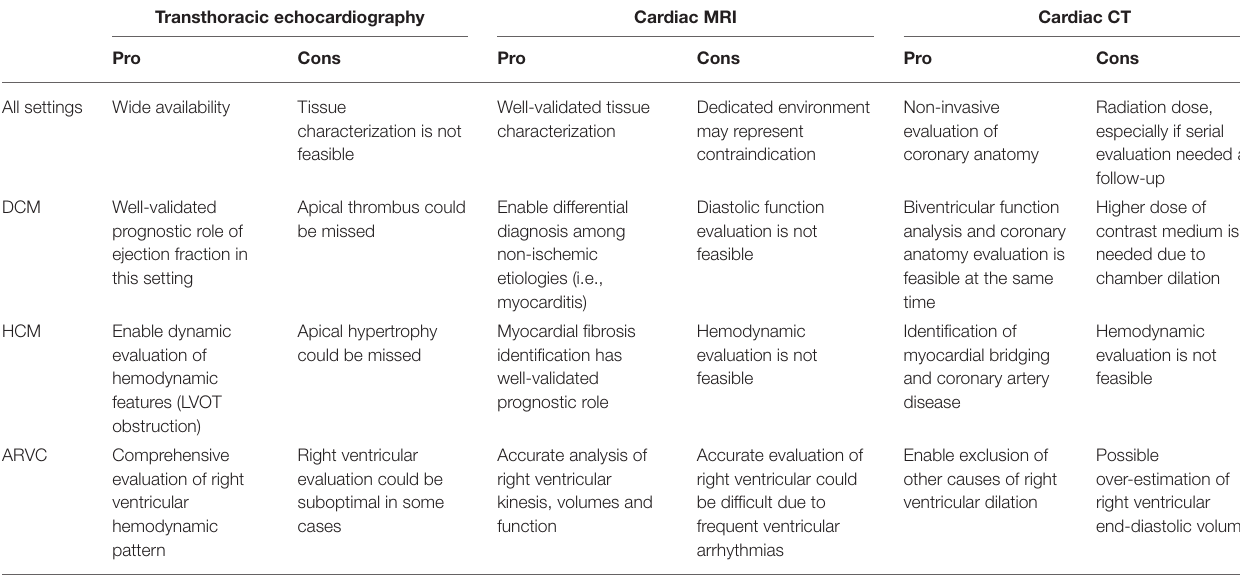
TABLE 1 | Main pro/cons features of CCT compared with other imaging modalities according to different clinical